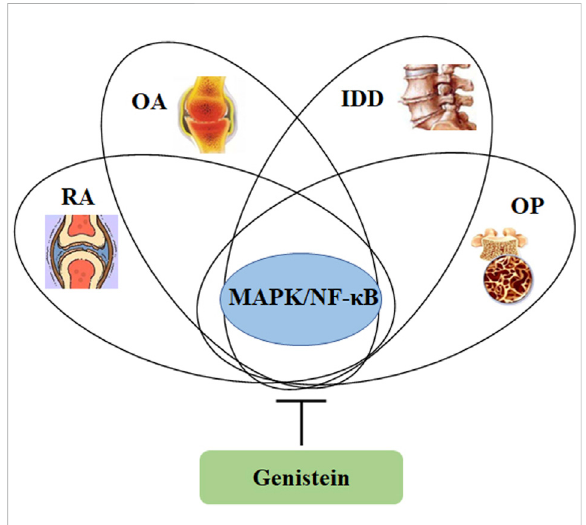
FIGURE 5 Genistein can inhibit the activity of MAPK/NF- κ B signaling pathway, which is involved in the pathological development of osteoporosis, intervertebral disc degeneration, osteoarthritis, and rheumatoid